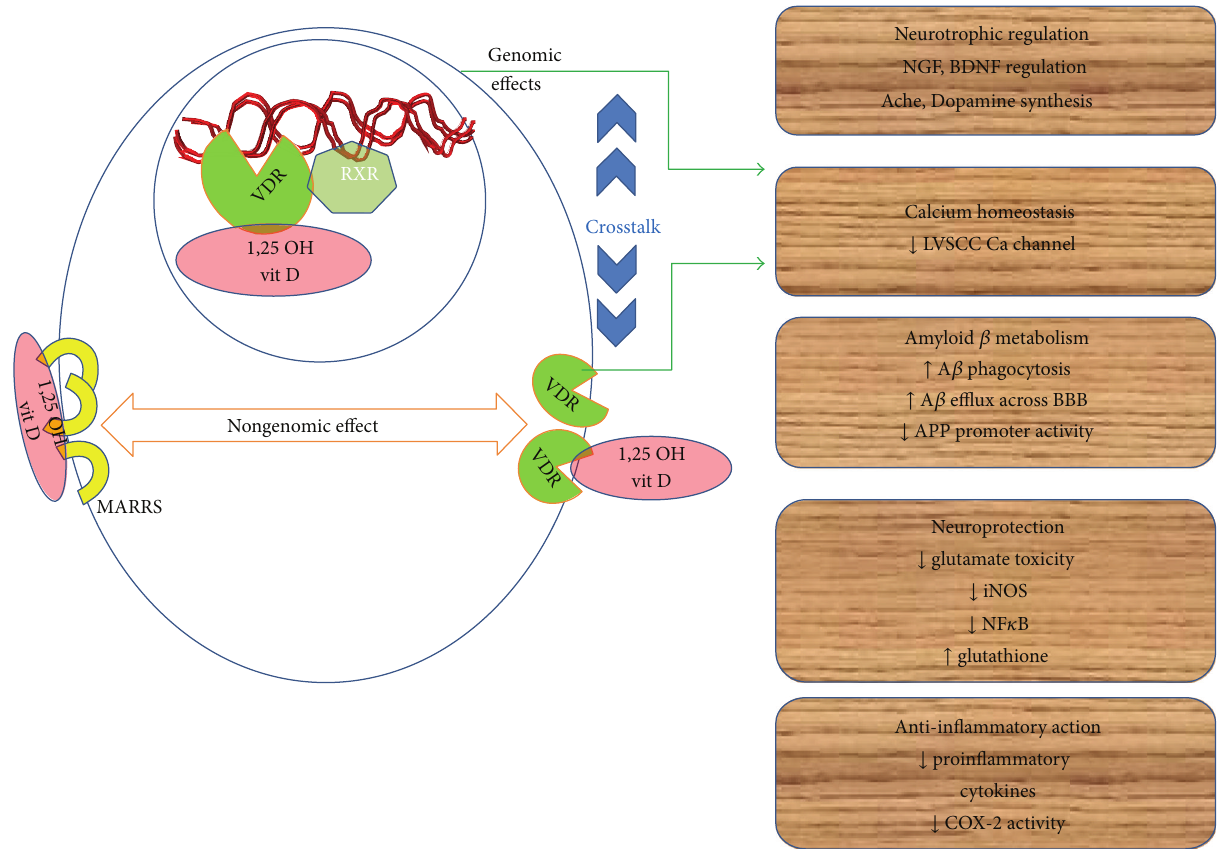
Figure 2: Mechanisms of 1,25 OH vitamin D mediated multitargeted neuroprotection in AD. VDR: vitamin D receptor, RXR: retinoid X receptor, MARRS: membrane associated rapid response receptors, and LVSCC: L voltage sensitive calcium